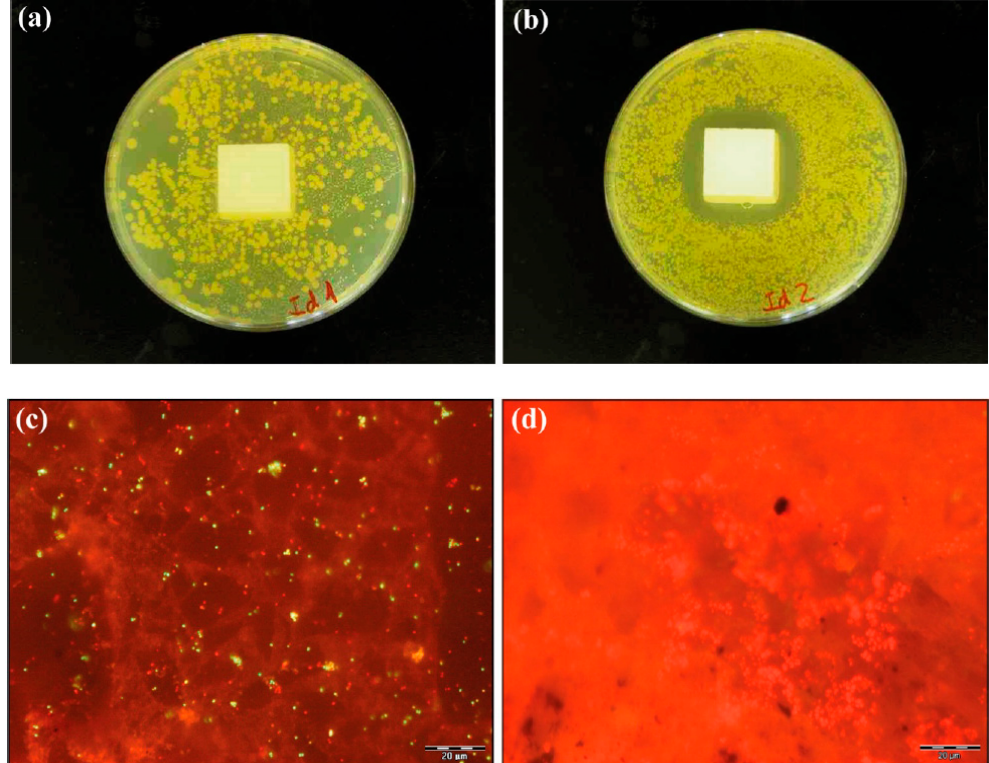
Figure 1. Bacterial inhibition on polyester surfaces with the presence of bacterial colonies of S. aureus in TSA agar incubated for 24 h at 37 °C: ( a ) bacterial colonies growing on a surface not treated with triclosan tested in dry test conditions; ( b ) bacterial inhibition on a surface treated with 400 ppm of triclosan in humid conditions. Epifluorescence microscopy images of S. aureus cells stained with the LIVE/DEAD ® kit (Molecular Probes, Eugene, OR, USA) after 24 h incubation: ( c ) presence of S. aureus live cells (green) and dead or injured (red) cells on a surface not treated with triclosan; ( d ) inhibition of S. aureus growth on a surface treated with 400 ppm of triclosan.